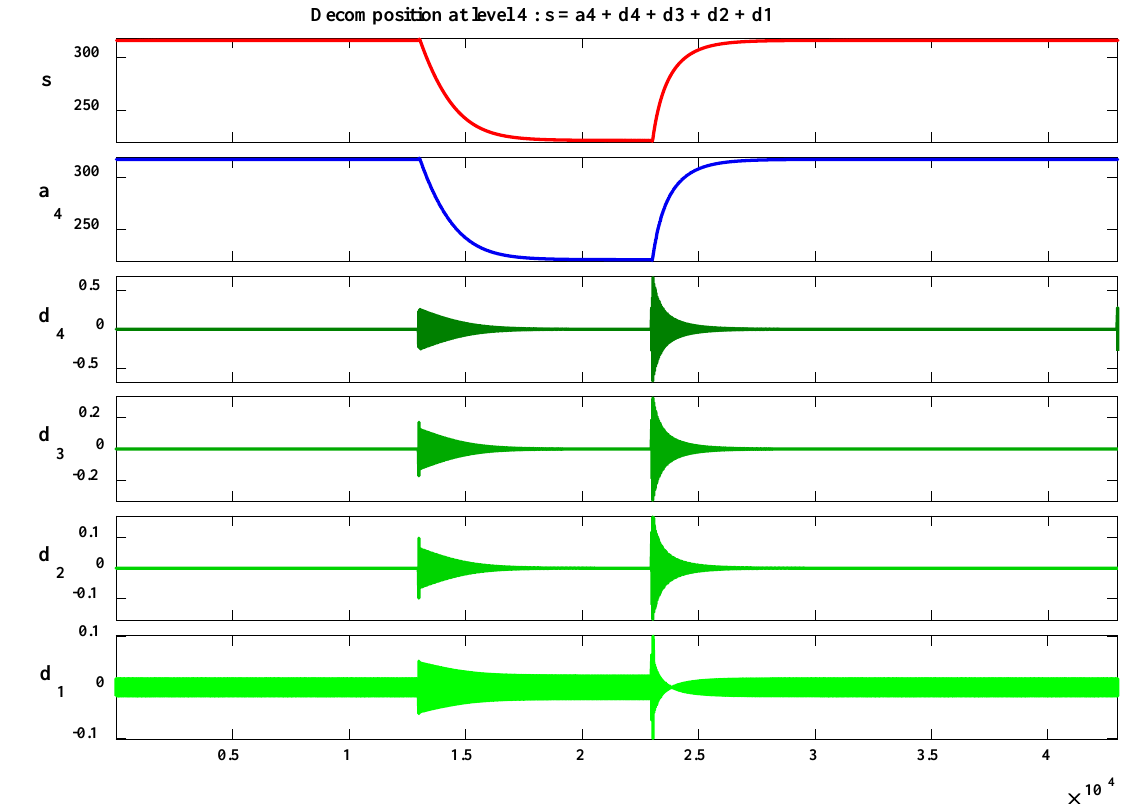
Figure 5. FDIA based on raising the voltage reference waveform amplitude: ( a ) Voltage waveform,( b ) Wavelet decomposi- Figure 5. b) Wavelet decomposition. tion.